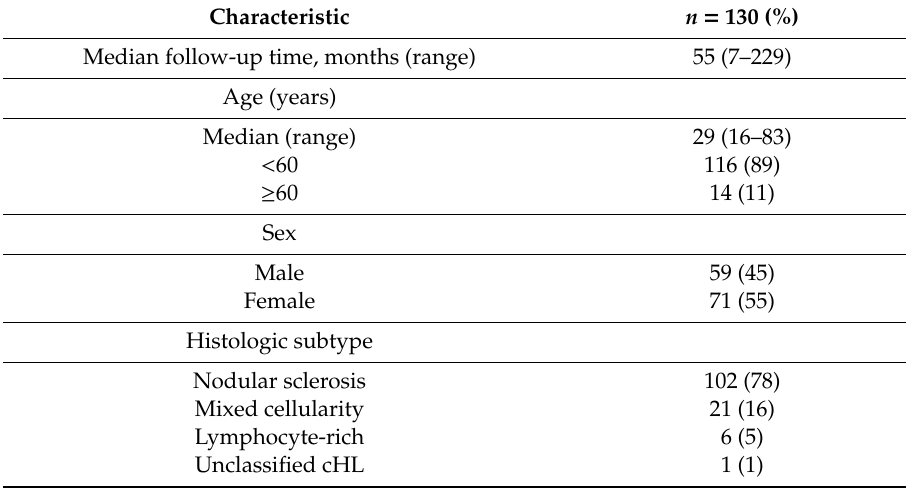
Table 1. Patient demographics and